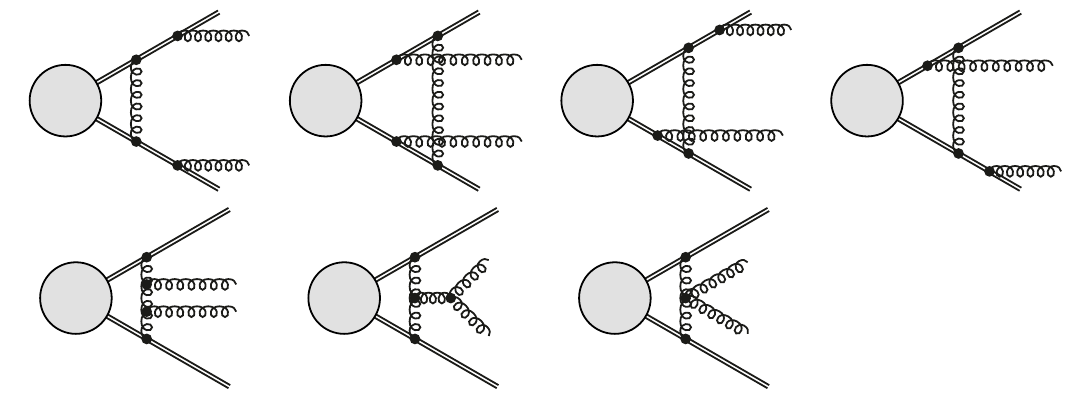
Figure 7 . Diagrams with two Wilson lines that contribute to J (1) J (0) and ∆ J (1) . Description as in figure 3.